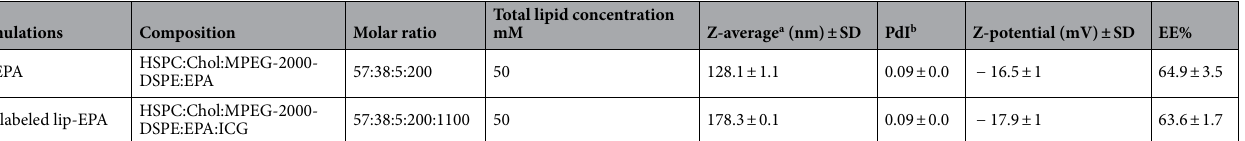
Table 3. The physicochemical properties of liposomal formulations of Lip-EPA and ICG-labeled Lip-EPA and percentage of encapsulation efficacy. (mean ± SD; n = 3).